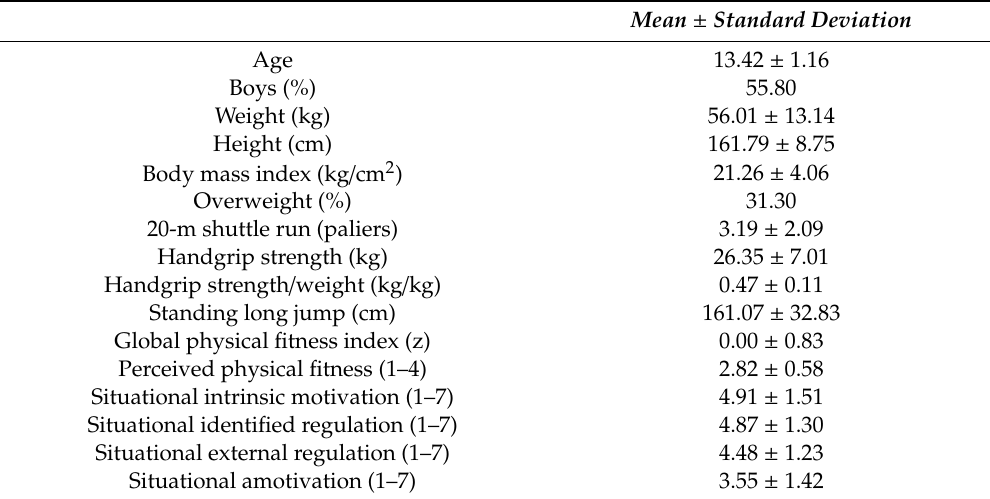
Table 1. Characteristics of the sample.